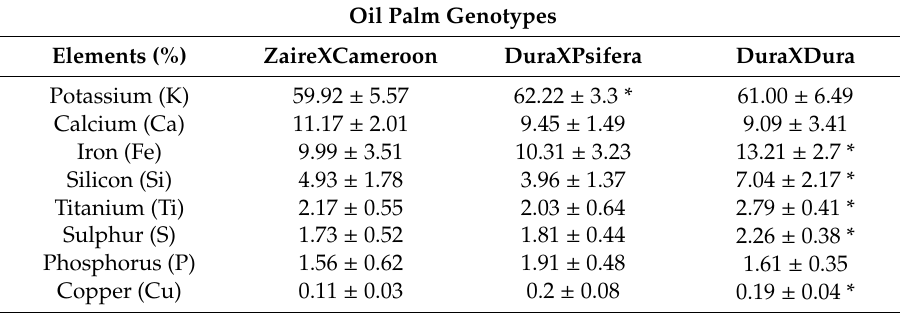
Table 3. Elemental nutrient deposition (%) in root tissues of one-year-old oil palm